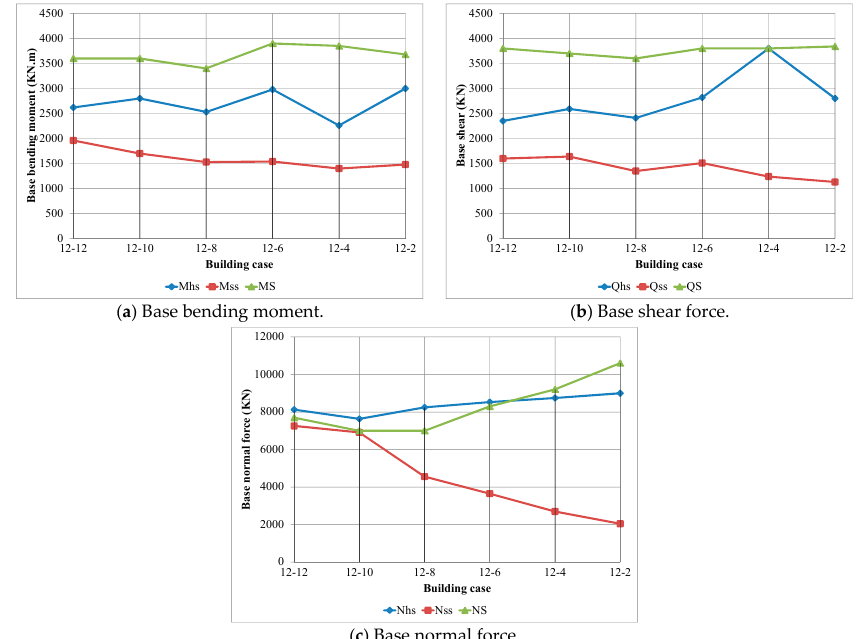
Figure 16. Straining actions at the base of the single and the two adjacent buildings with unequal foundation levels and SSI.